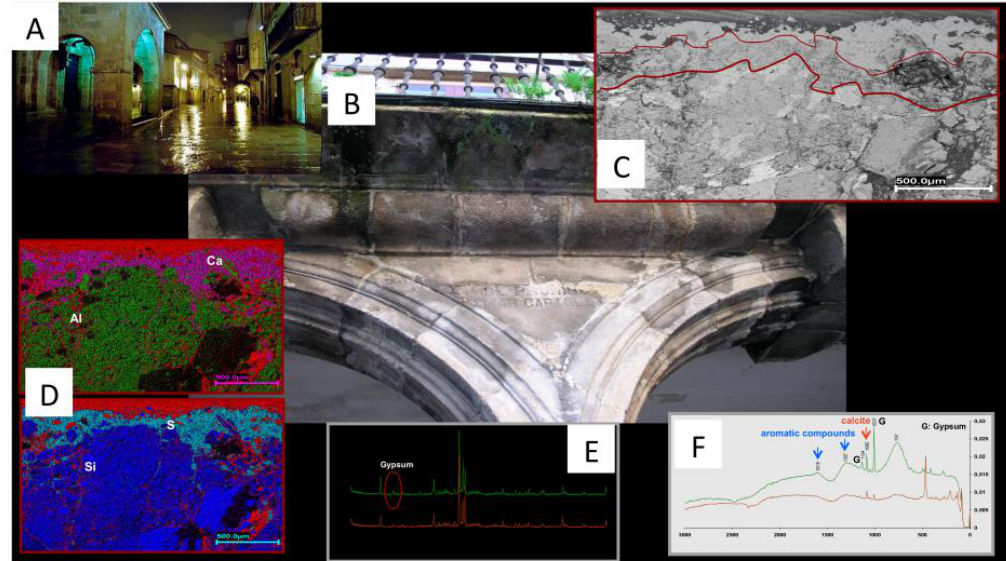
Figure 1. Covering layer on the exterior wall of Number 2 Toural Square (Santiago de Compostela). ( A ) Entrance to the Toural Square, ( B ) detail of the sampled area, ( C ) SEM picture of a cross-section of the covering layer, ( D ) EDS of the cross-section, ( E ) XRD spectra of the covering layer (green line) and of the granite underneath the covering layer (brown line), and ( F ) IR / Raman spectra of the covering layer (green line) and of the granite underneath the covering layer (brown